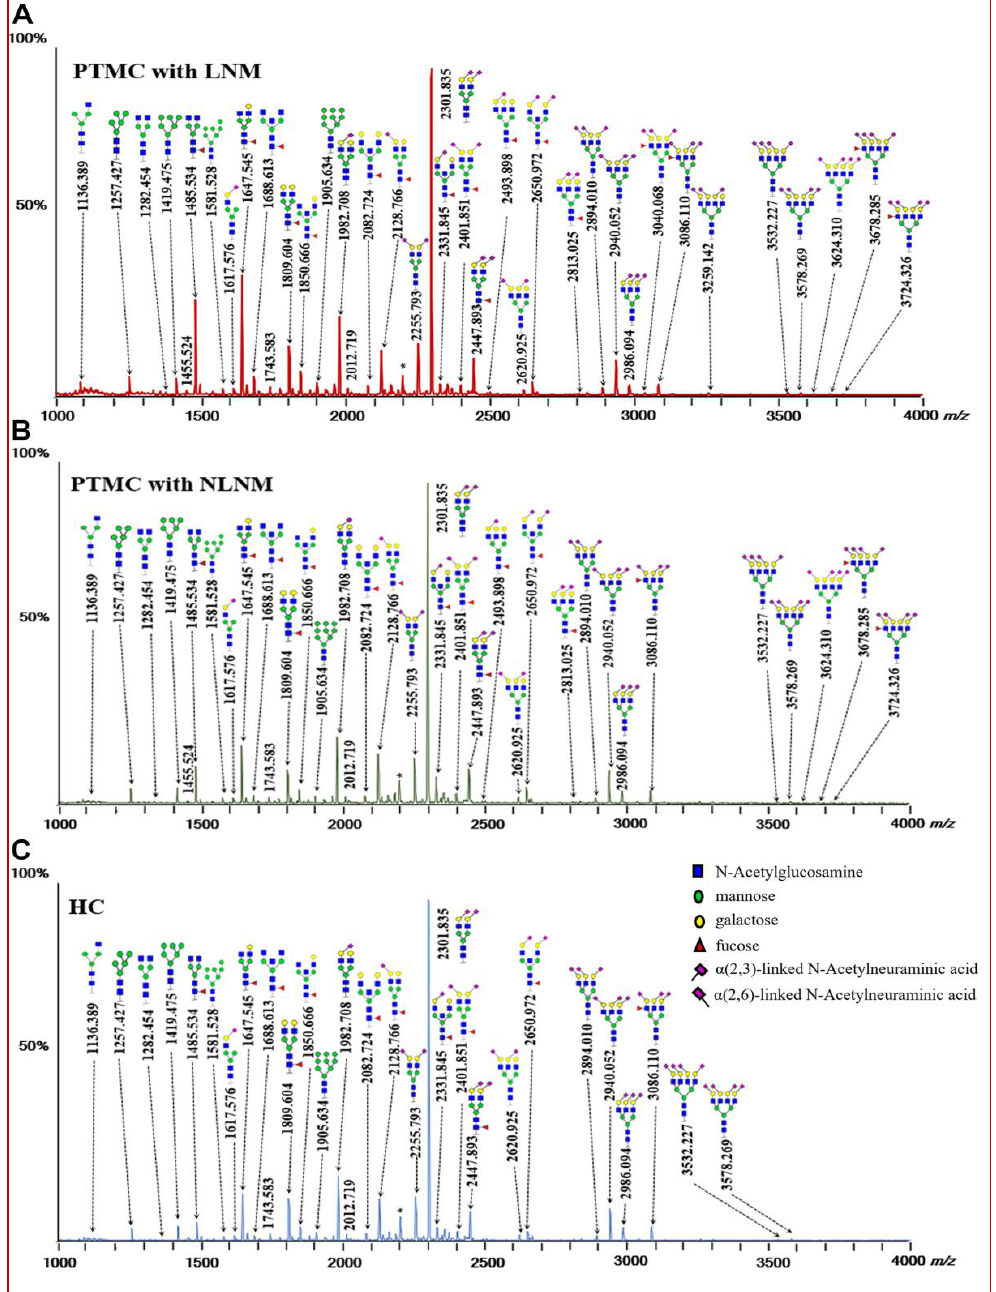
Figure 1. The representative matrix-assisted laser desorption/ionization time-of-flight mass spec- trometry (MALDI-TOF-MS) spectra of serum protein N -glycome for (A) PTMC with LNM, (B) PTMC with NLNM, and (C) HC. Spectra were recorded in positive-ion reflection mode on a Bruker rapifleXtreme mass spectrometer. Major N -glycan peaks are annotated and assigned to composi- tions, and the presence of structural isomers cannot be excluded. The asterisks (*) represent by- products. Abbreviations: PTMC, papillary thyroid microcarcinoma; LNM, lymph node metastasis; NLNM, non-lymph node metastasis; HC, healthy control.